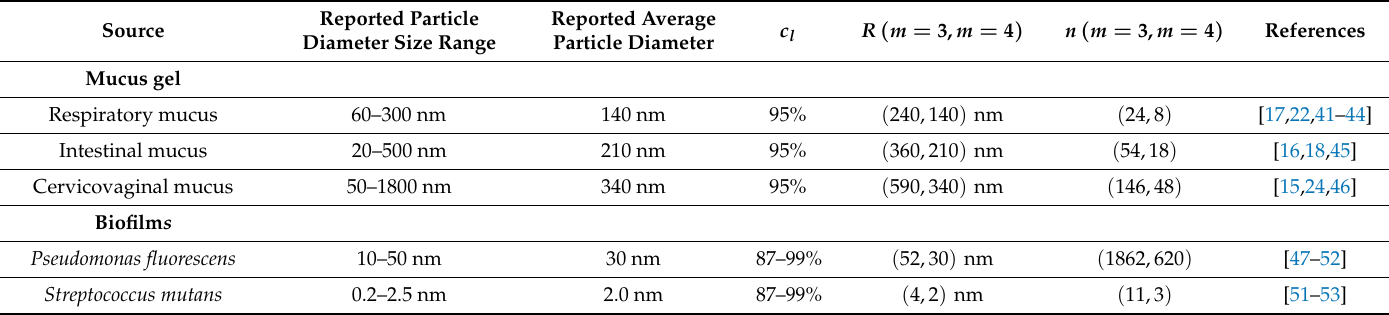
Table 1. The structure of different bio-gels based on the penetration of particles in the absence of an external